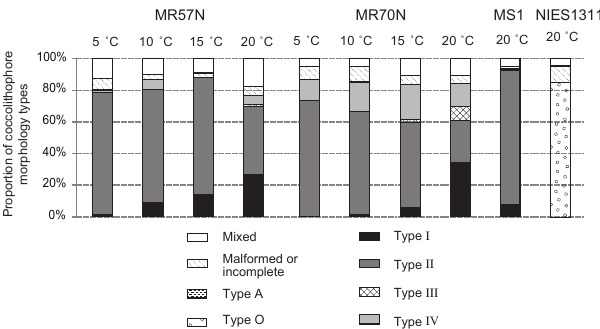
Figure 6. Proportions of morphotypes of coccoliths and coccol- ithophore cells in E. huxleyi strains MR57N, MR70N, MS1, and NIES1311. Types I–IV: submorphotypes; Types A and O: morpho- types reported previously (see text). Note that morphotype A (Type A) was not observed in strains shown in this figure.